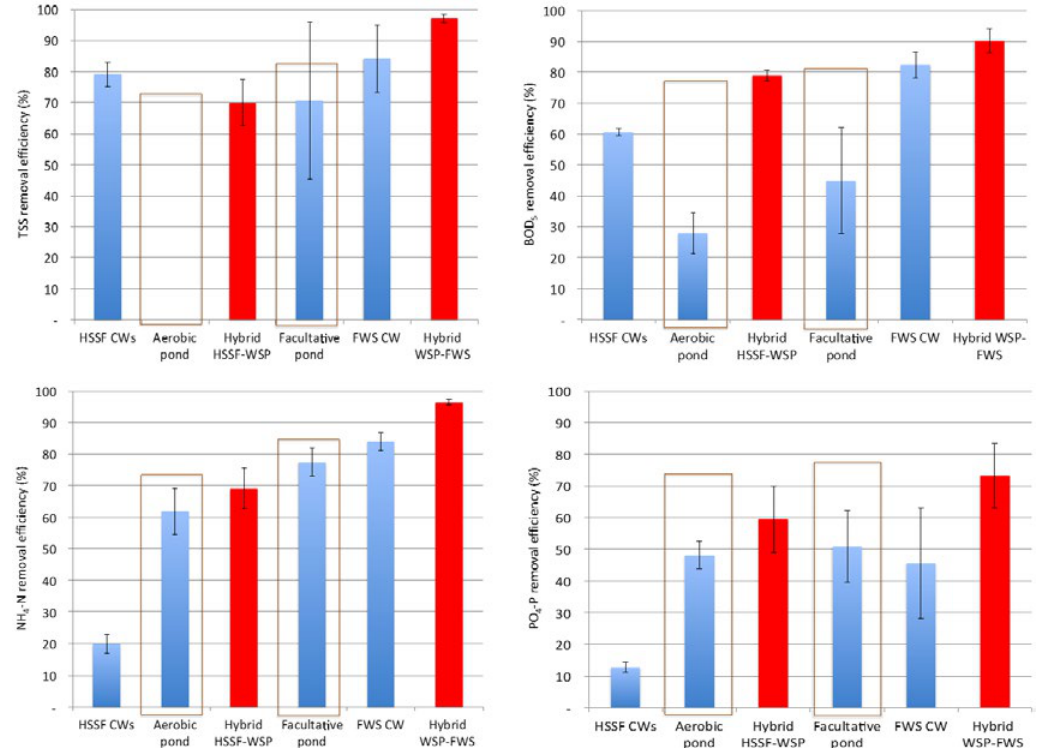
Fig. 7: Impact of waste stabilization pond (WSP) on hybrid WSP-CW system’s